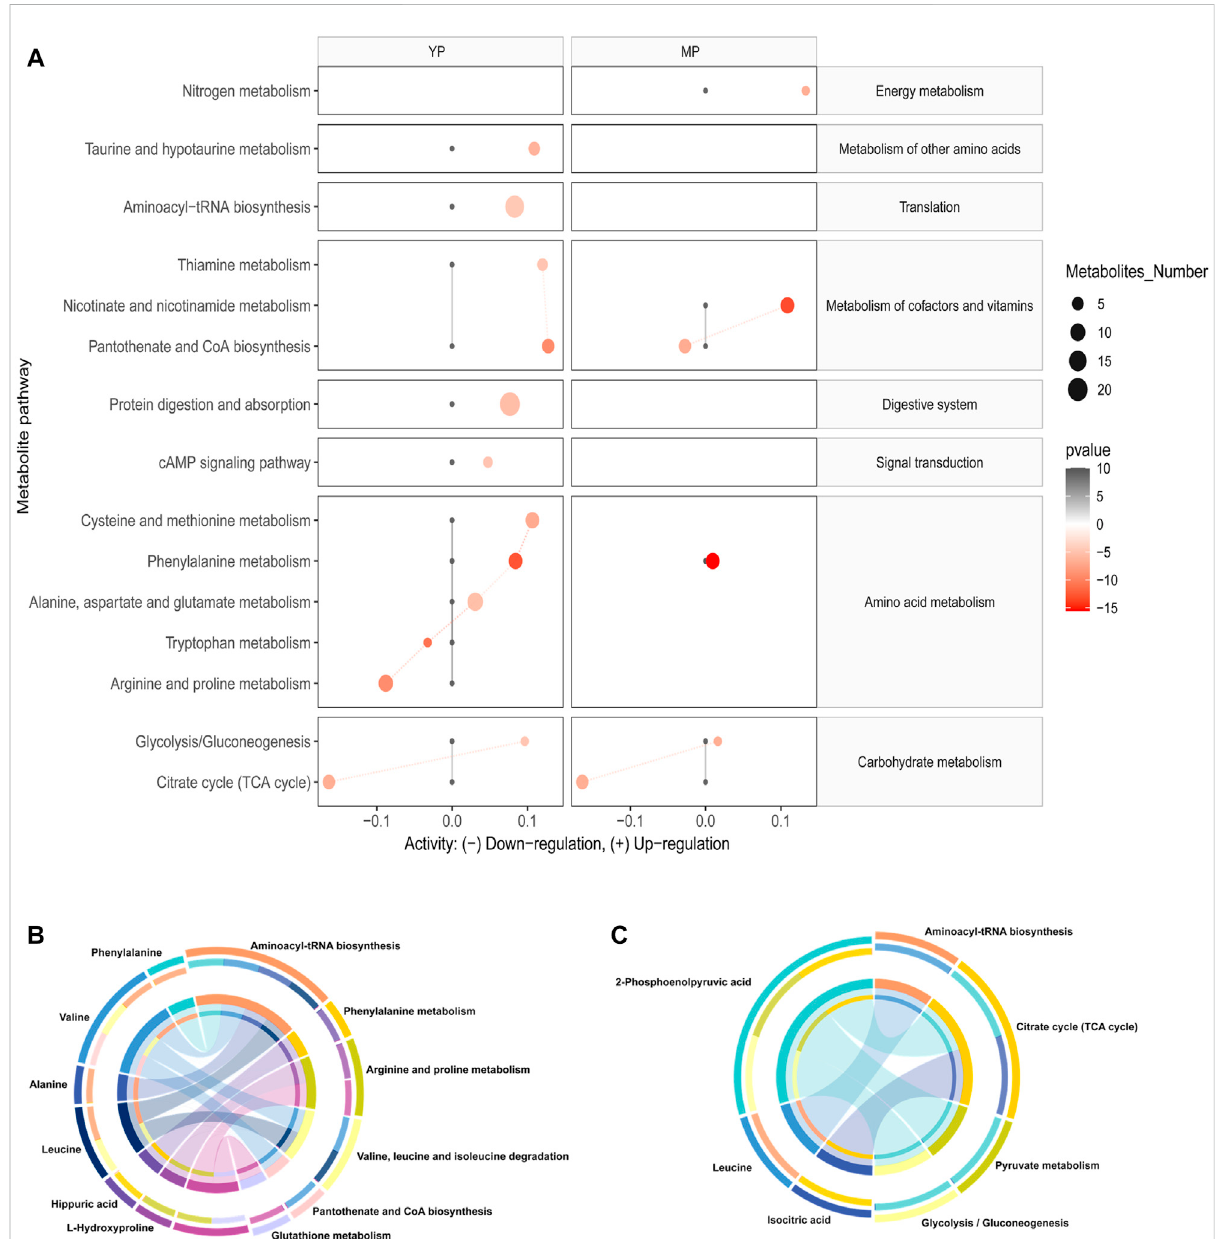
FIGURE 4 (A) Activitiesofmetabolicpathwaysinliver-basedontheexosomalmetabolomeofPCOSandnormalmiceatyoungandmiddleage.Blackdots represent metabolic activities in exosome or liver tissue from normal mice that were adjusted to 0. Red dots represent metabolic activities in exosome or liver tissue from PCOS mice. The metabolic activities were visualized using the log 2 scale. The dot size indicates the number of metabolites ofthepathway, andthedot colorindicates thep-value. Circos plots displaytheconnectivitybetweenmetabolitesand pathways at (B) young and (C) middle